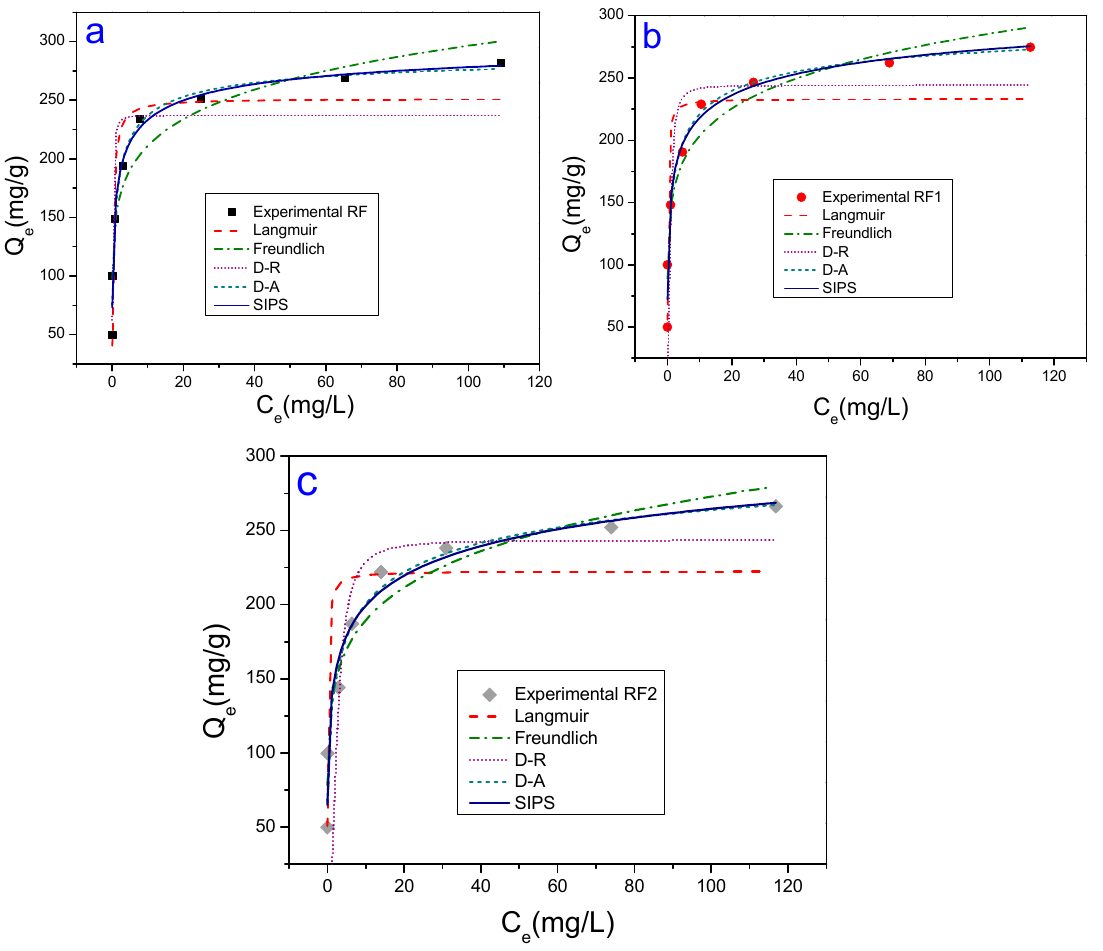
Figure 7. Adsorption isotherms of MB in room temperature conditions, adsorbent mass 100 mg, using t c in 90 min: ( a ) adsorbent RF; ( b ) adsorbent RF1; and ( c ) adsorbent RF2.